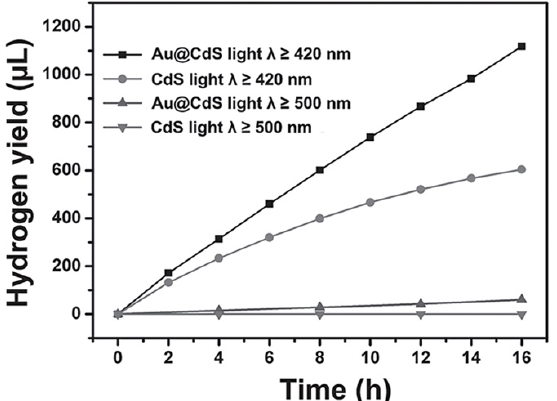
Figure 11. Photocatalytic water splitting of core-shell Au@CdS and CdS nanoparticles under irradiation of visible light with wavelength more than 420 nm and 500 nm, respectively. Reproduced from [133], with copyright permission from John Wiley & Sons, 2014.